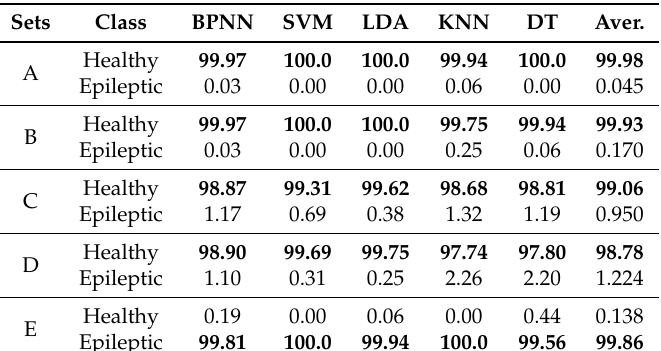
Table 3. Classification results of the five classifiers on all five data-sets of Case 1 (Back-Propagation Neural Network (BPNN), Support Vector Machine (SVM), Linear Discriminant Analysis (LDA), K-nearest neighbour (KNN), Decision Tree (DT), average value (Aver.)).